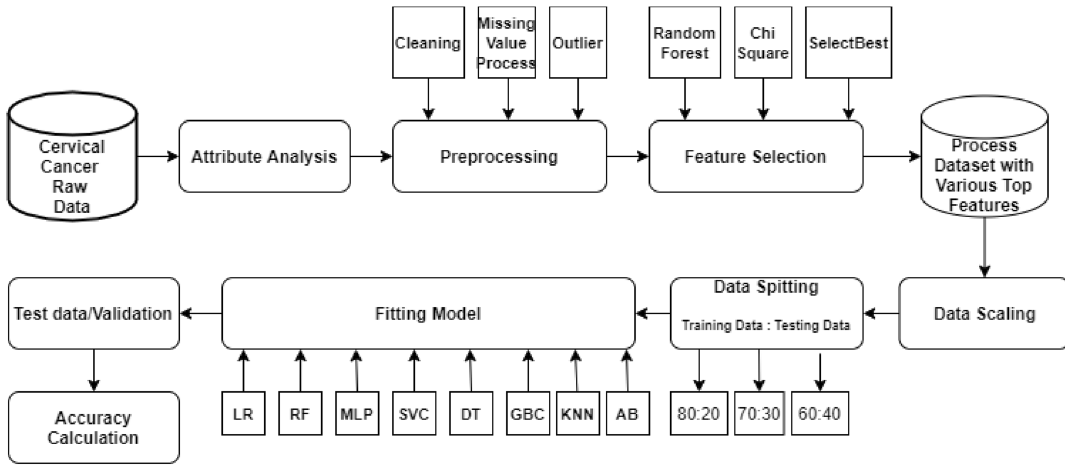
Fig. 1 The proposed